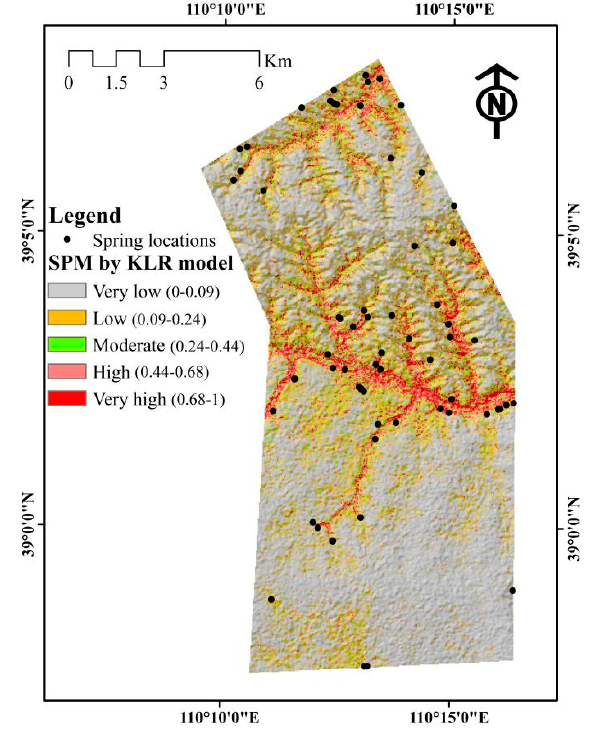
Figure 5. Groundwater spring potential map by the KLR model. Table 4. Percentages of groundwater spring-potential classes.